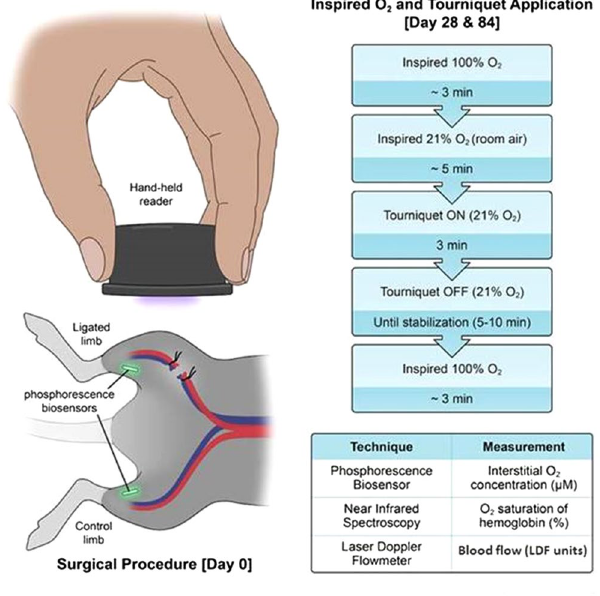
Figure 8. Overview of experimental design. Day 0: bilateral and symmetric subcutaneous implantation of biosensors, with unilateral ligation of femoral vessels on one leg. A similar scheme without the surgery was performed for subsequent measurement days. Days 28 & 84: simultaneous real-time measurement with three techniques (biosensor, NIR spectroscopy, laser Doppler) while the rats were subjected to a series of